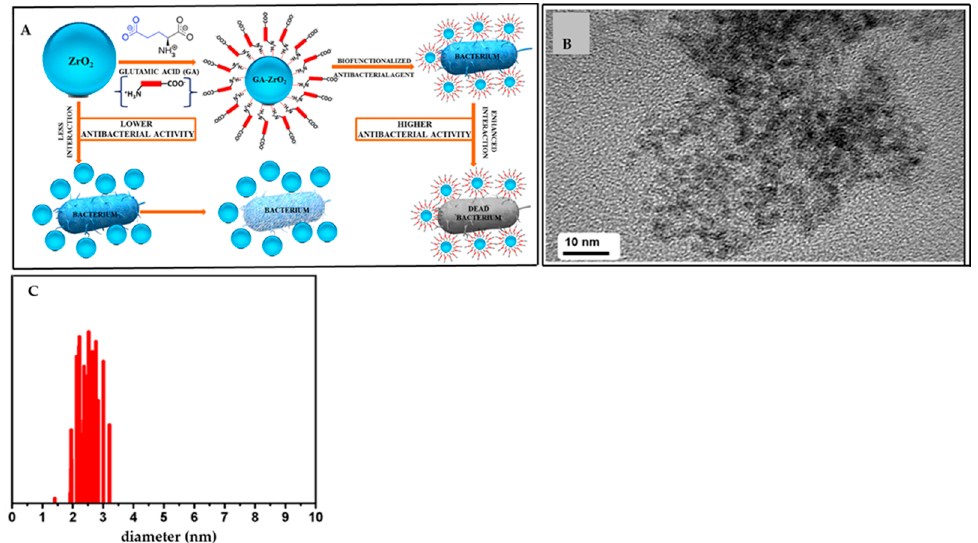
Figure 2. Schematic representation of the synthesis of functionalized ZrO 2 NPs and their antimicrobial behavior (Panel [ A ]), TEM image of ZrO 2 NPs (Panel [ B ]), and the corresponding particle size distribution (Panel [ C ]). (Reproduced with the permission from Ref. [28]. Copyright © 2020 American Chemical Society.)